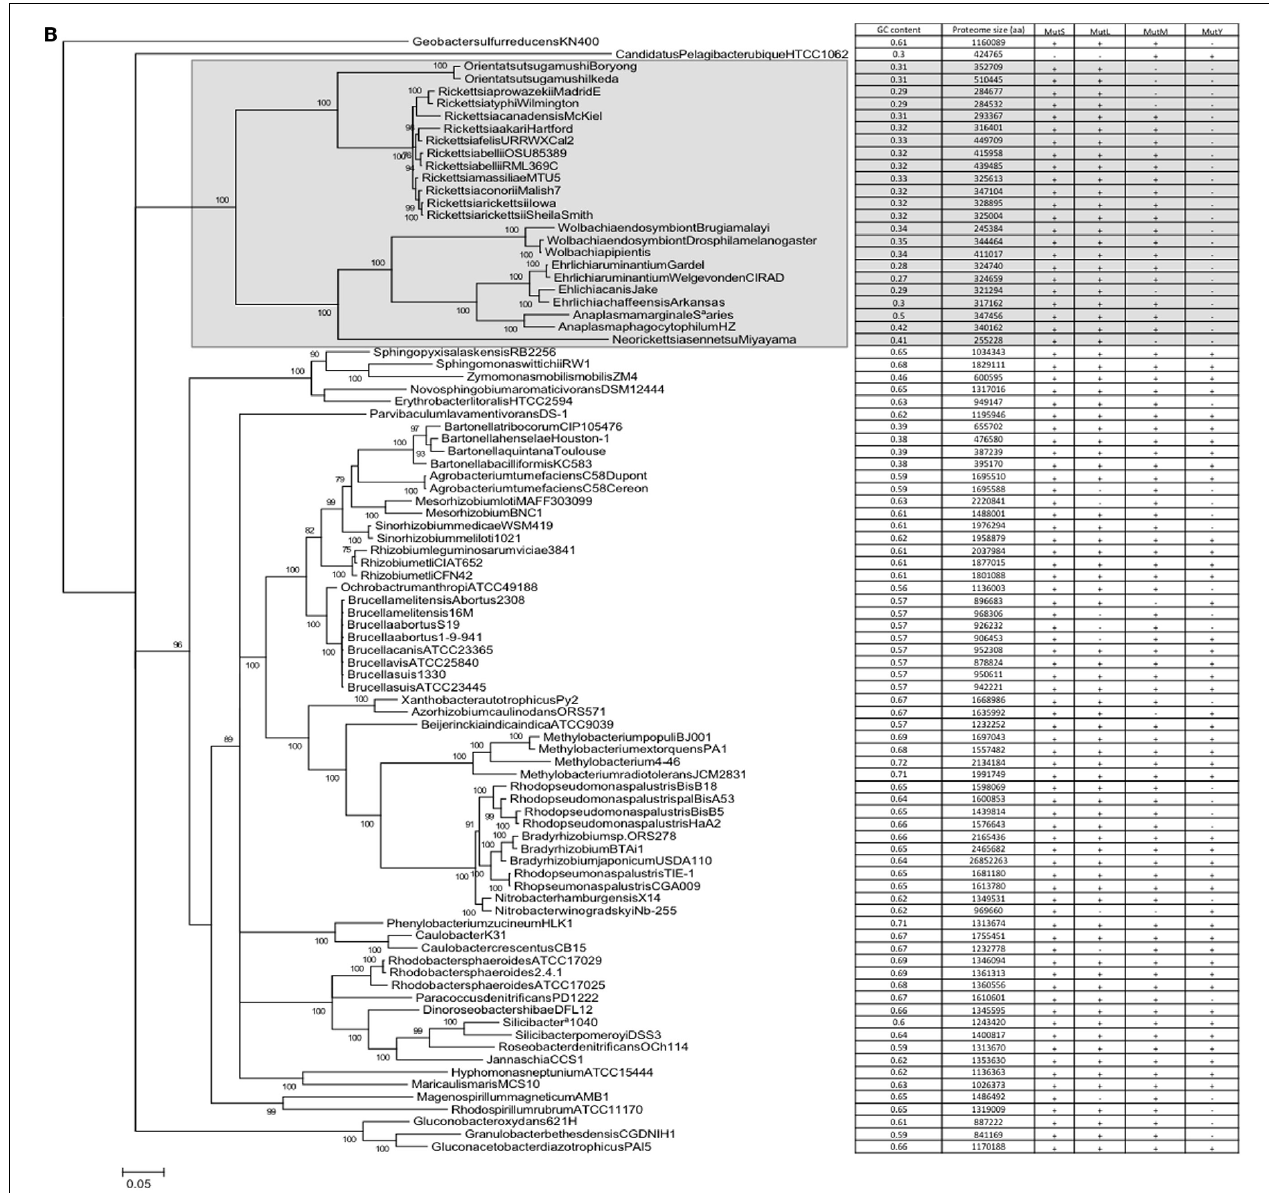
FIGURE 2 | Phylogenetic trees of the cyanobacteria and alphaproteobacteria, with genome GC contents and presence of DNA repair genes (A) Cyanobacteria; (B)Alphaproteobacteria. Trees were constructed as described in Section “Materials and Methods.” Numerals refer to posterior